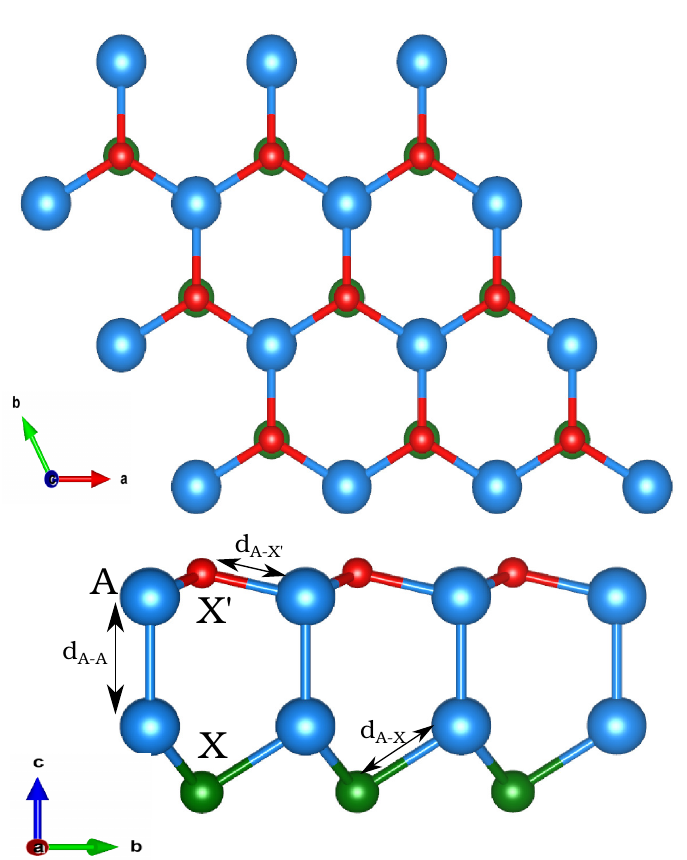
these monolayers from their parent binary structure.